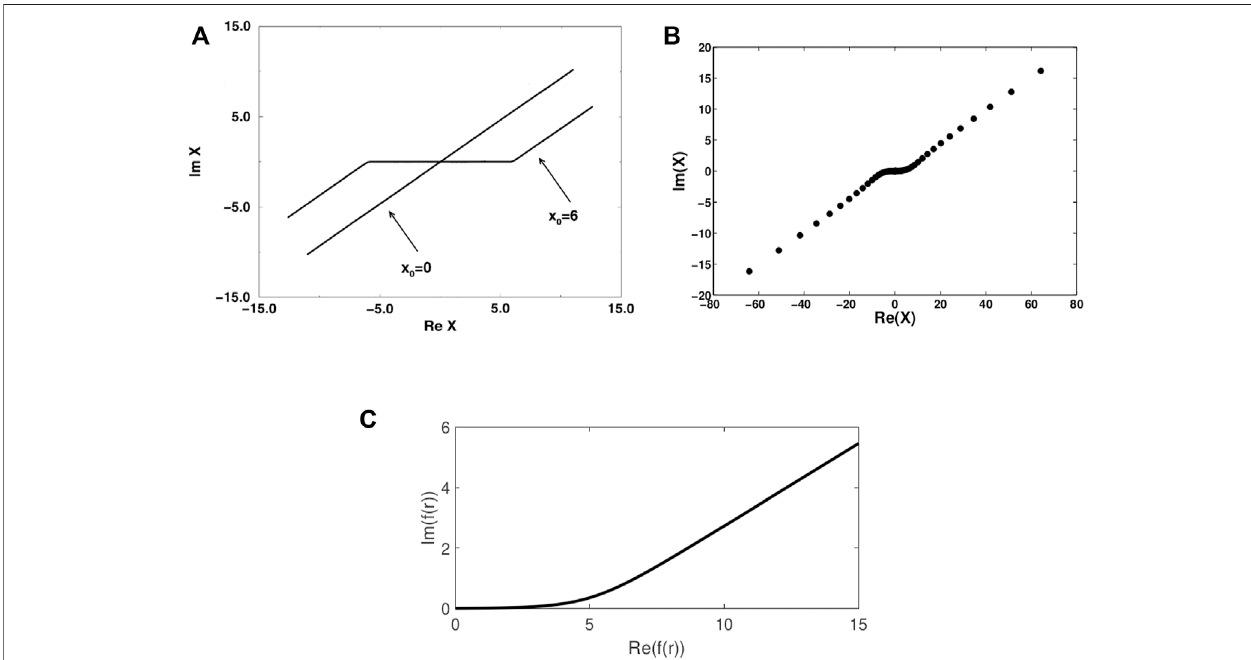
FIGURE 4 | (A) A schematic representation of a uniform ( x 0 = 0) and exterior ( x 0 = 6) complex contours of integration for calculating the non-Hermitian Hamiltonian matrix elements (Reprinted from Ref. [2], Copyright (1998), with permission from Elsevier). (B) and (C) presents smooth exterior complex contours from